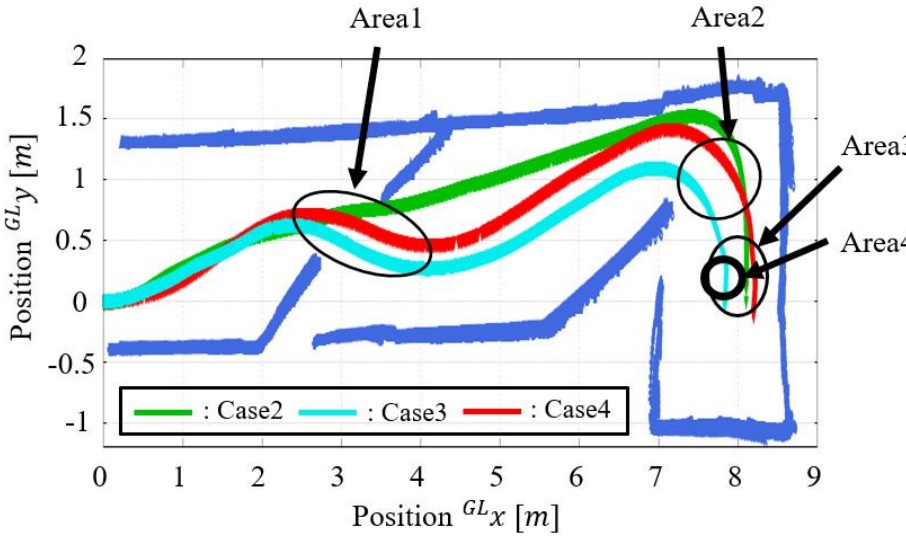
Figure 15. Experimental trajectories of Case 2, Case 3, and Case 4 for Subject A.